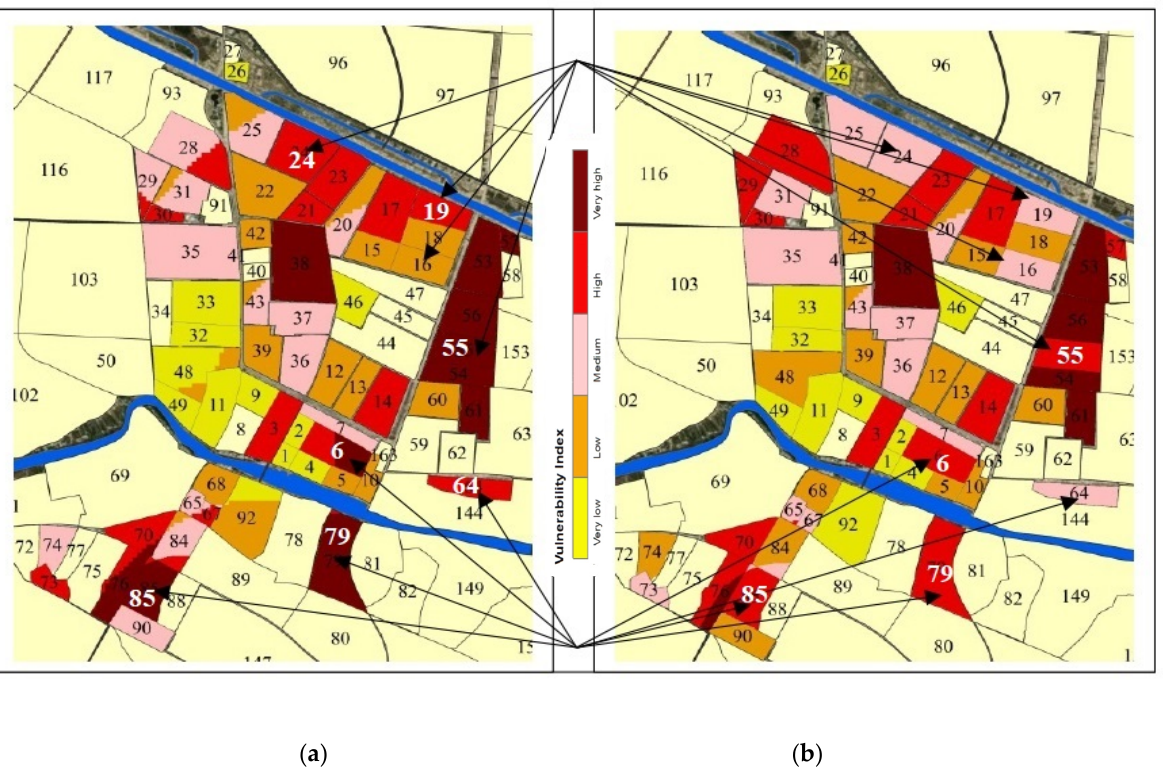
Figure 24. Change in a neighbourhood’s classification between the first scenario ( a ) and the second scenario ( b ).